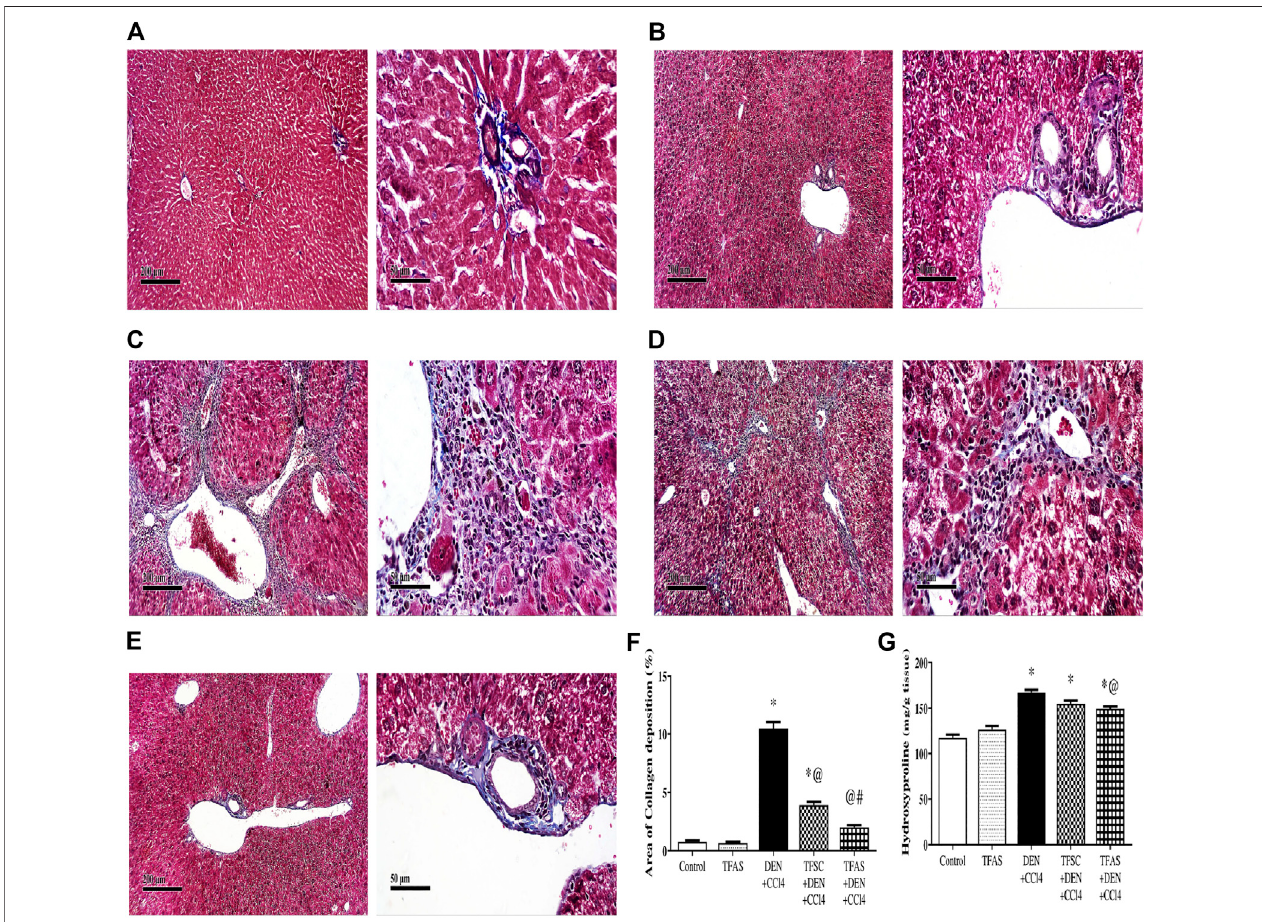
FIGURE6| Effect of TF-ODNs on collagen deposition and hydroxyproline content in theliver. (A) Masson ’ s Trichome-stained liver section ofcontrolgroup, (B) TFAS group, (C) DEN+CCl4 group where obvious periportal proliferation of fi broblasts are detected as well as bridging of fi broblasts with abundant formation of collagen fi bers, (D) TFSC+DEN+CCl4 group and (E) TFAS+DEN+CCl4 group showed signi fi cant reduction of activated fi broblasts and collagen fi bers, (F) Percentage areaof collagen deposition and (G) liver hydroxyprolinecontent in differentstudy groups. Dataareexpressed asmean ± SEM (n (cid:1) 8). (*), (@) and (#) indicate signi fi cant difference from Control, DEN+CCl4 and TFSC+DEN+CCl4, respectively at P < 0.05 using one-way ANOVA followed by Tukey- Kramer post-Hoc test. DEN: N-diethyl nitrosamine; CCl4: carbon tetrachloride; TFSC: scrambled tissue factor oligodeoxynucleotides; TFAS: antisense tissue factor